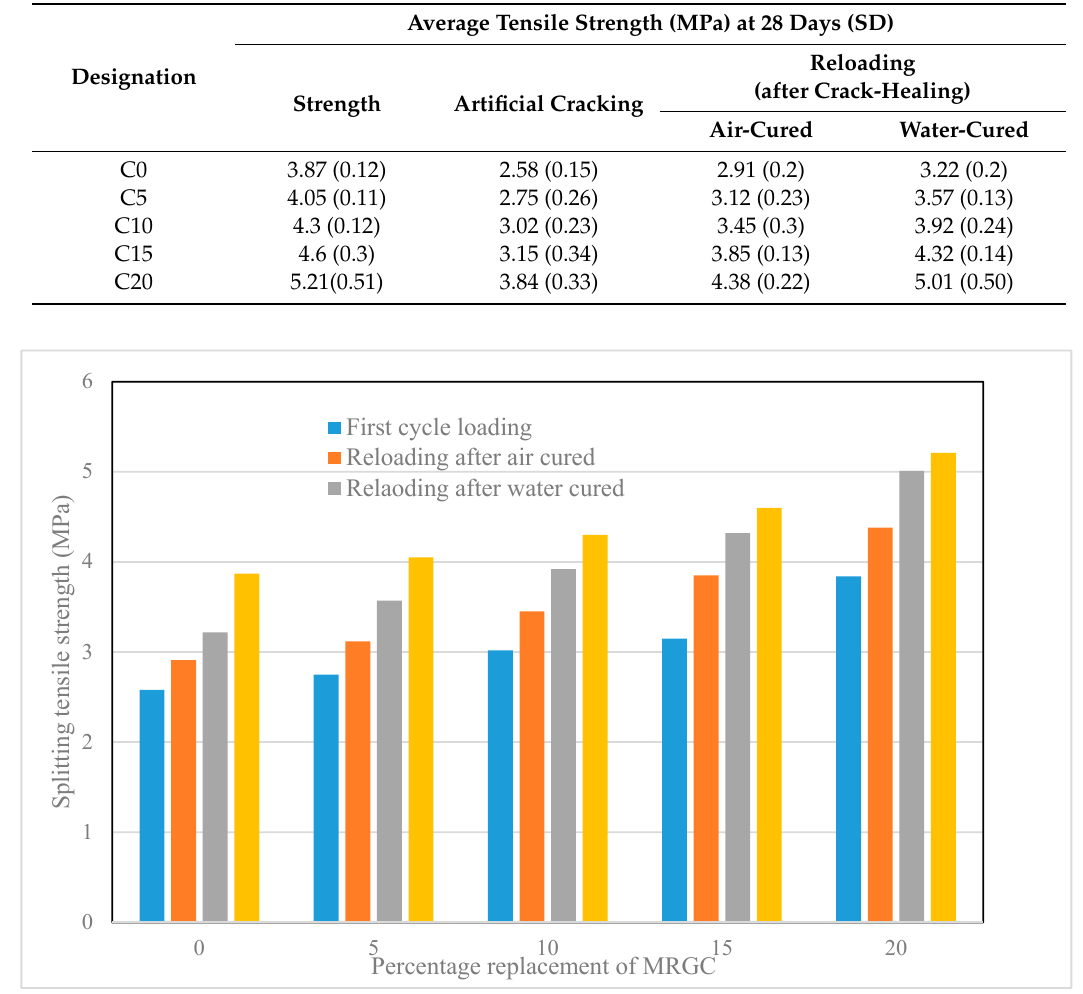
Table 6. Splitting tensile strength regained due to the crack healing effect of MRGC.